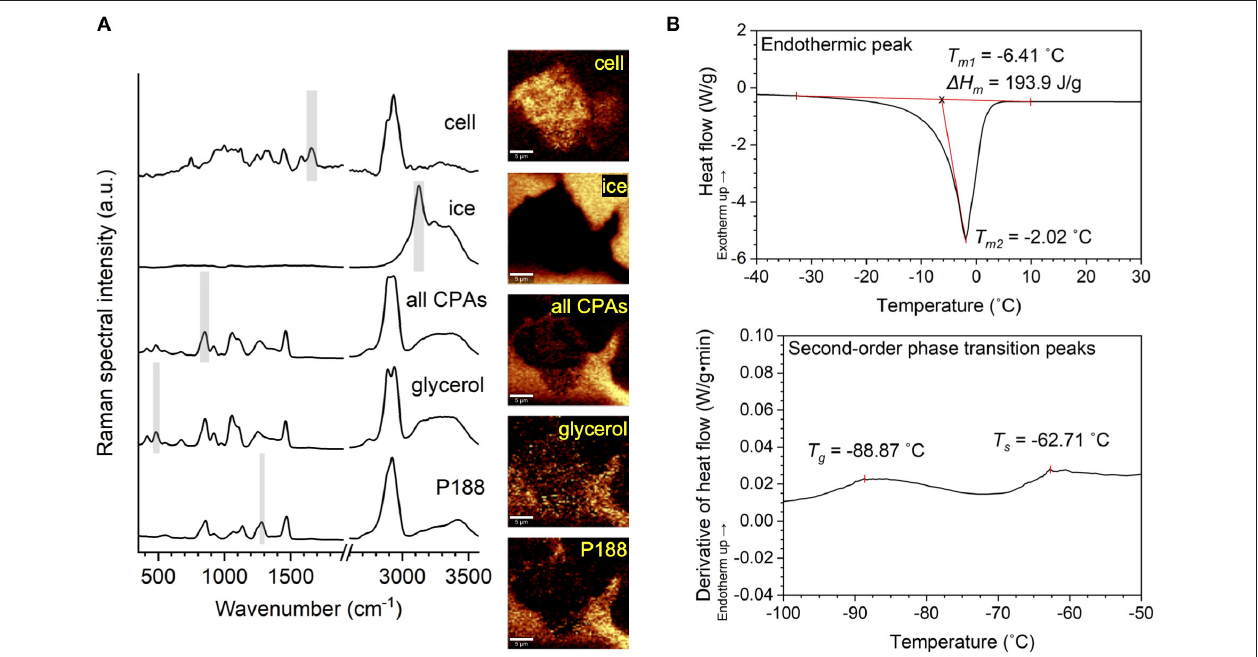
FIGURE 1 | Illustration of Raman and differential scanning calorimetry (DSC) methodology. (A) Raman spectra of a hiPSC aggregate, ice, all cryoprotective agents (CPAs) combined, glycerol and poloxamer 188 (P188), as well as Raman heat maps rendered from the spectra based on the characteristic Raman signal shown by shaded region, respectively. (B) Top: DSC thermogram showing endothermic peak (melting). The melting temperature was defined as the onset of melting ( T m1 ) for evaluation of thermophysical properties and the peak of melting ( T m2 ) for the interpretation of undercooling. Enthalpy of melting ( 1 H m ) was defined as the area under the curve of the endothermic peak. Bottom: First derivative of SC thermogram showing second-order phase transitions. Glass transition temperature ( T g ) and softening temperature ( T s ) were visualized by deriving heat flow with respect to time and defining T g and T s as two local maxima along the derivative curve.